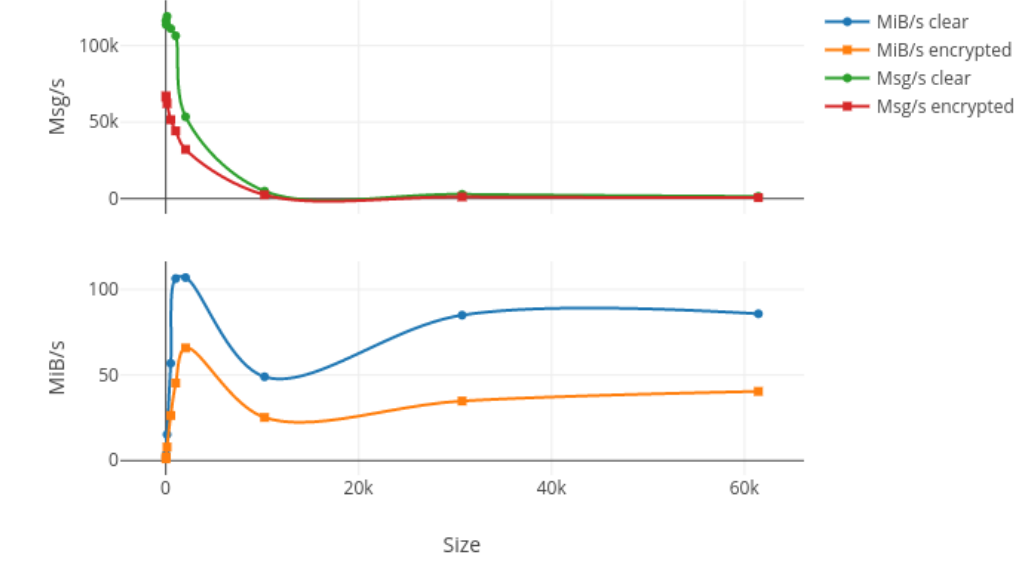
Figure 7. Bandwidth results in terms of Msg/s and MiB/s for 10,000 packets sent on the laptop with increasing message size in both encrypted and clear modes. Msg: messages per second; MiB: mebibytes per second.